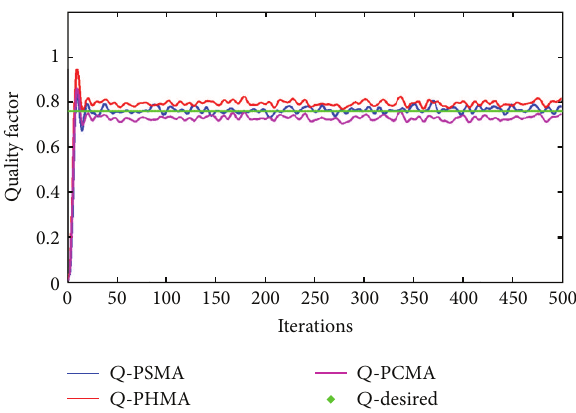
Figure 6: Optimized values of quality factors for PSMA, PCMA, and PHMA.